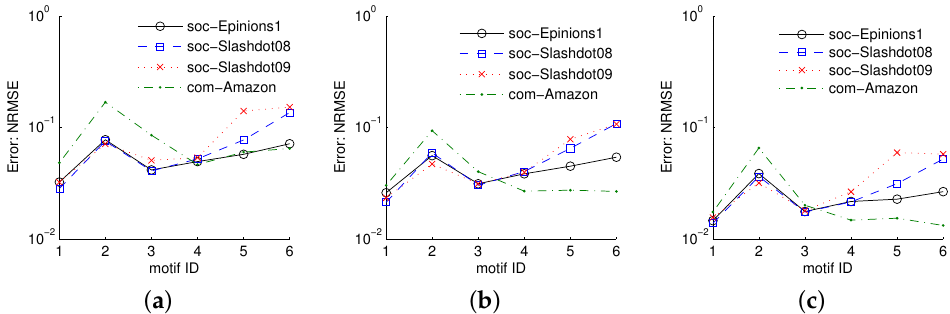
( 4 ) Figure 9. NRMSEs of ˆ n , the motif frequency estimates of four-node undirected motifs for p = 0.1, i and p = 0.2, respectively. Soc-Epinions1, soc-Slashdot08, soc-Slashdot09, and com-Amazon have 2.58 × 10 10 , 2.17 × 10 10 , 2.42 × 10 10 , and 1.78 × 10 8 four-node CIS, respectively: ( a ) p = 0.05; ( b ) p = 0.1; ( c ) p =